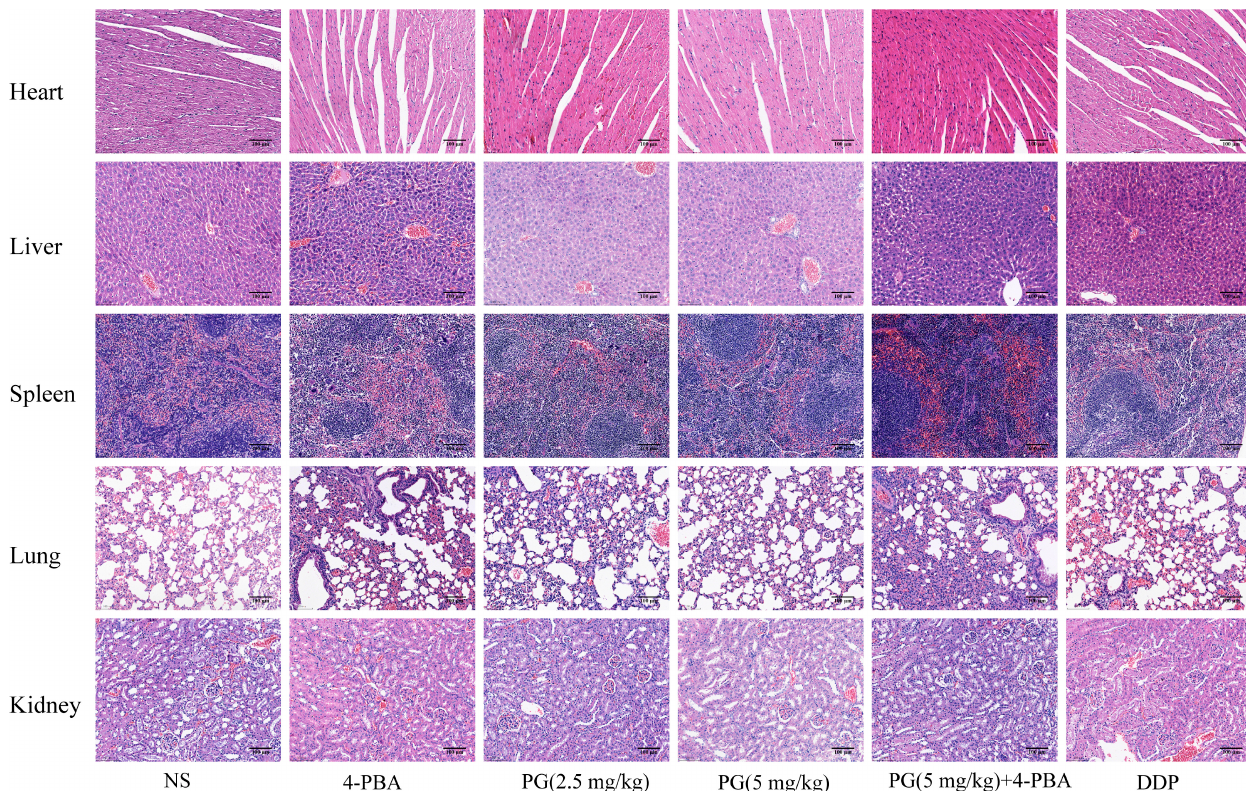
Figure 7. HE staining of heart, liver, spleen, lung, and kidney tissues of nude mice.